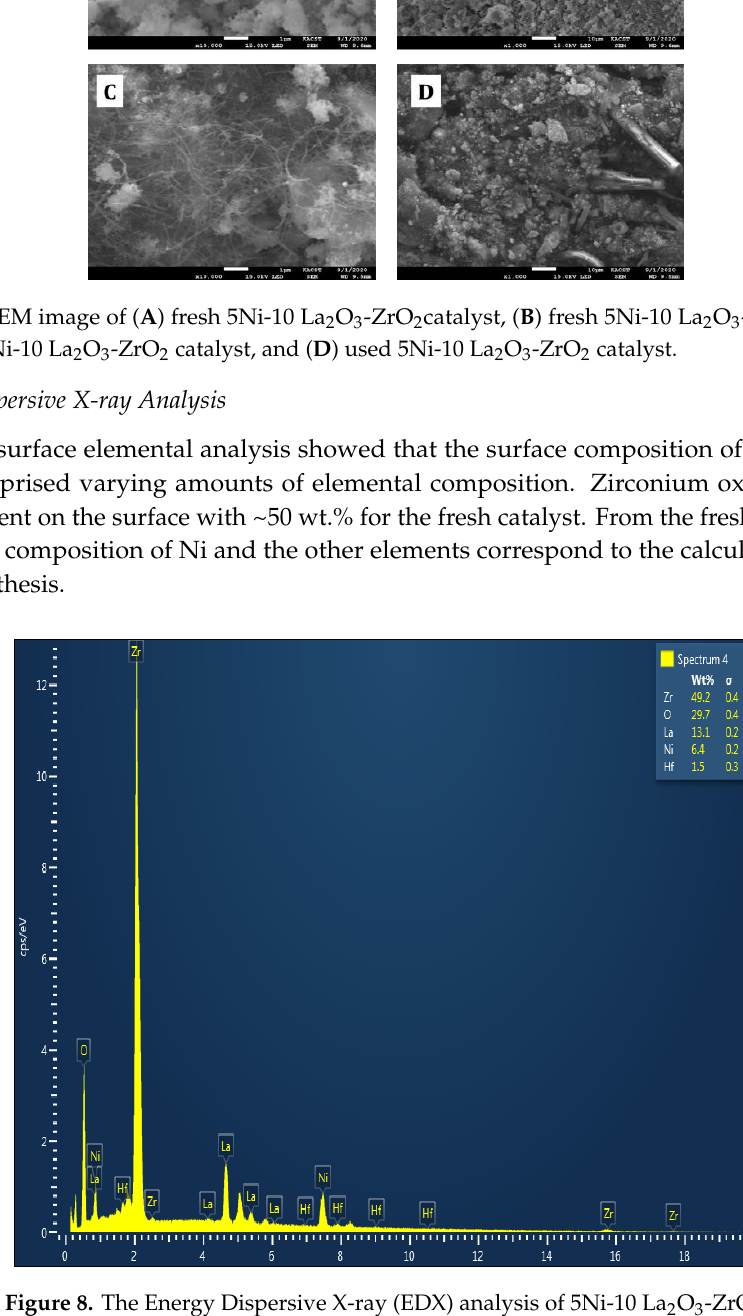
Figure 6. TEM image of ( A ) fresh 5Ni-10 La 2 O 3 -ZrO 2 catalyst, ( B ) fresh 5Ni-10 La 2 O 3 -ZrO 2 catalyst, ( C ) used 5Ni-10 La 2 O 3 -ZrO 2 catalyst, and ( D ) used 5Ni-10 La 2 O 3 -ZrO 2 catalyst.